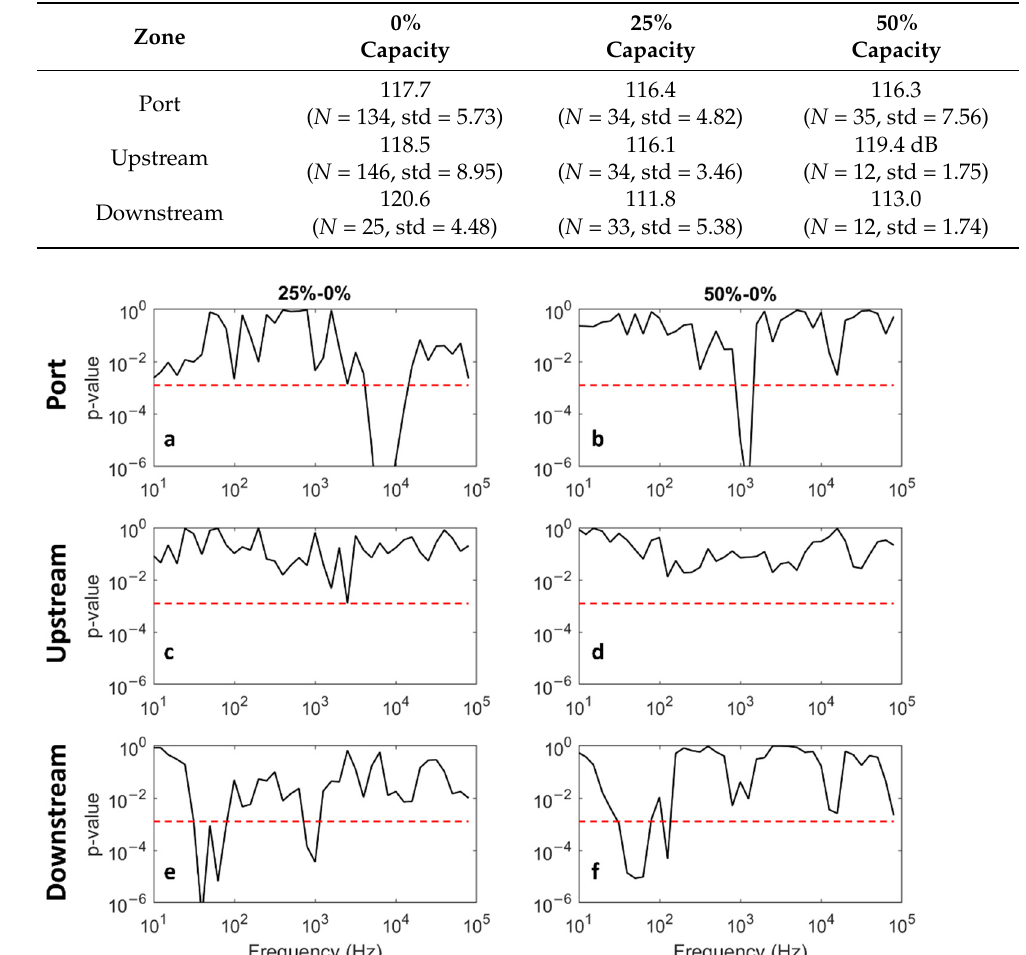
Figure 8. Results of pair-wise Mann–Whitney tests ( p -value) for the decidecade sound pressure levels comparing values at the 25% (panels a , c , e ) and 50% (panels b , d , f ) turbine power generation states with baseline noise levels at 0% in each zone. The frequency axis labels denote the lower limit of each decidecade frequency band. Red dash lines indicate 5% significance level, adjusted for multiple comparisons .